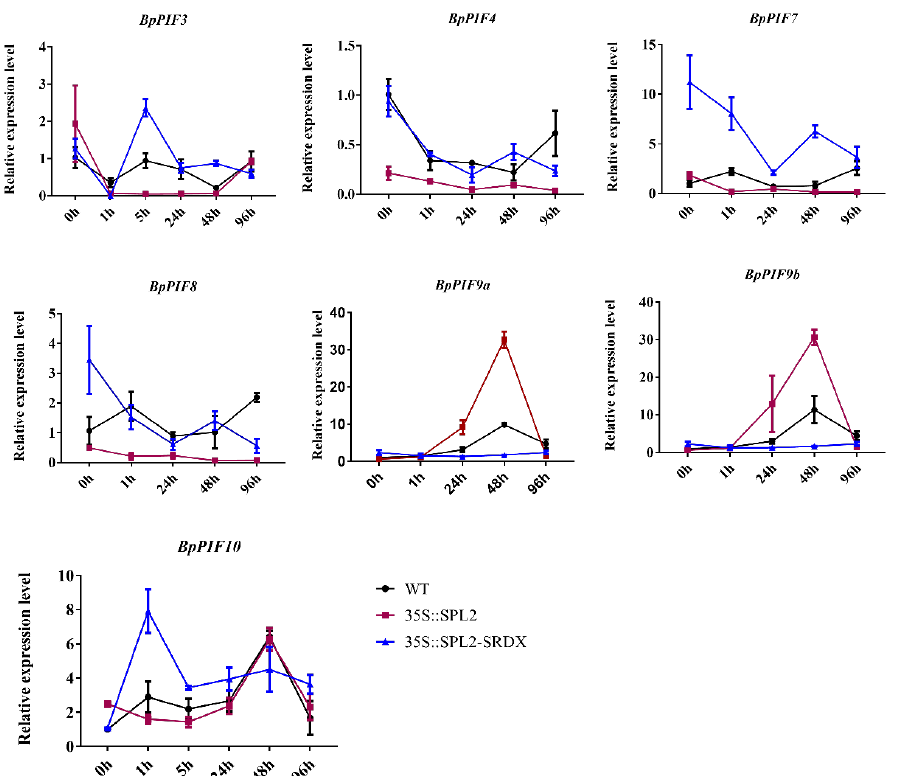
Figure 7. Relative expression levels of BpPIFs in adventitious root formation. The number on the X axis indicates the time of rooting induction (hour), The different colours of the lines represent different birch lines. Stars indicate significant differences between OE-, SRDX-, and WT ( p < 0.05) according to Duncan’s multiple range test, while the equals sign means non-specific difference. Expression levels were calculated based on the 2 − ∆∆ Ct method, with the zero-hour sample chosen as a reference.